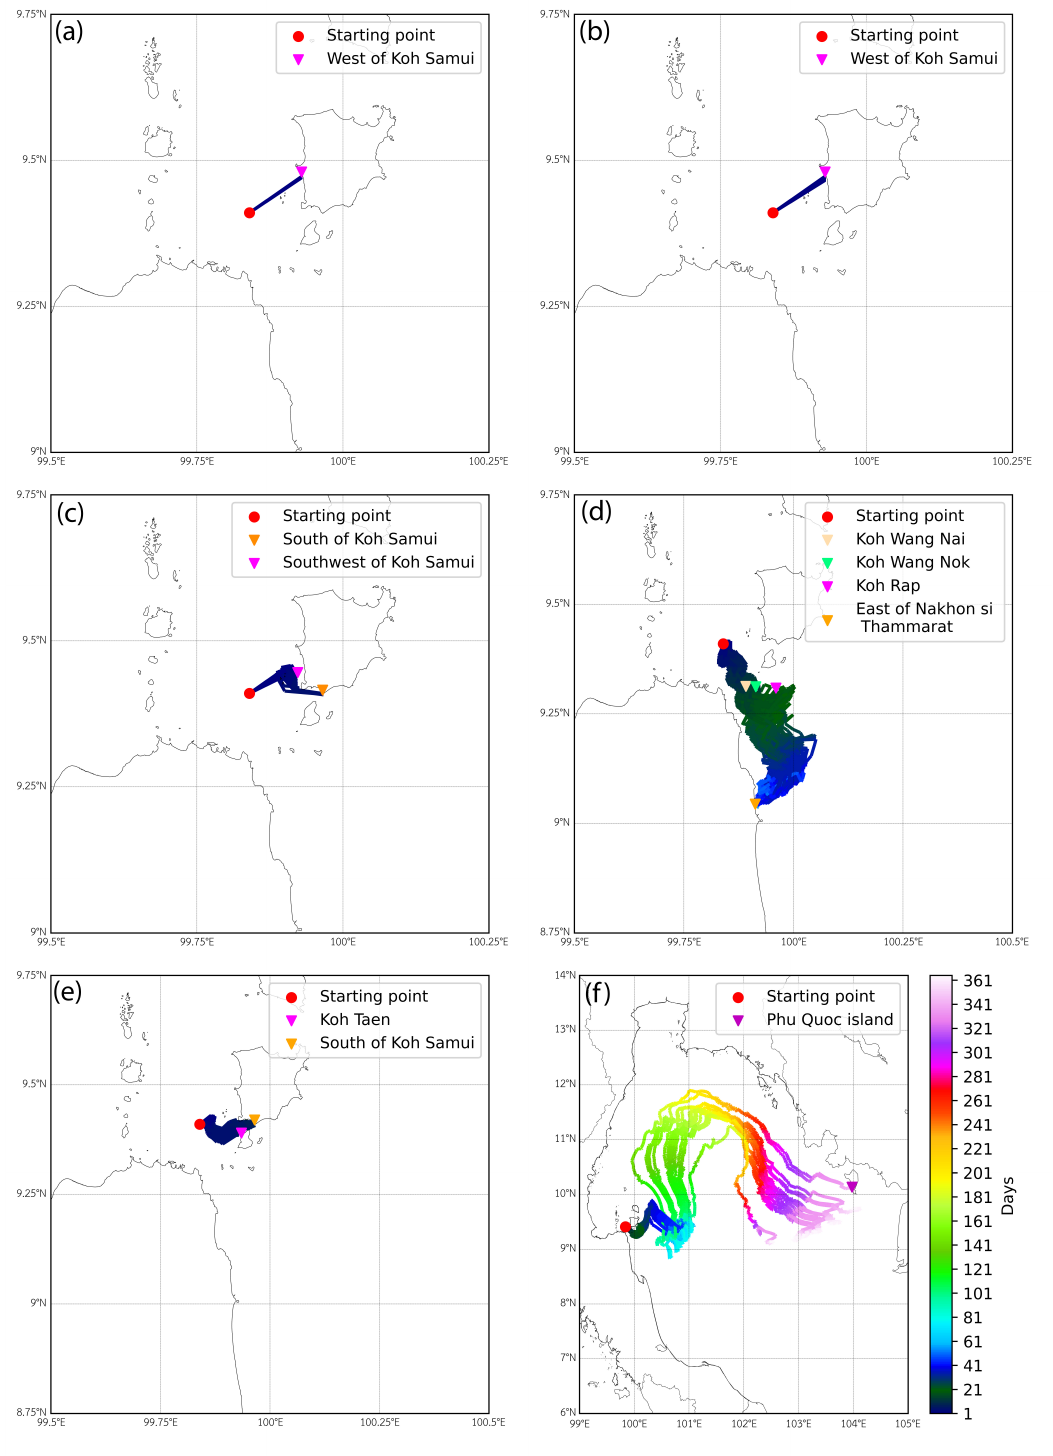
Figure 10. The path of marine debris depends on the buoyancy ratio ( a ) 100:1, ( b ) 10:1, ( c ) 1:1, ( d ) 0:1, ( e ) 1:10, and ( f )